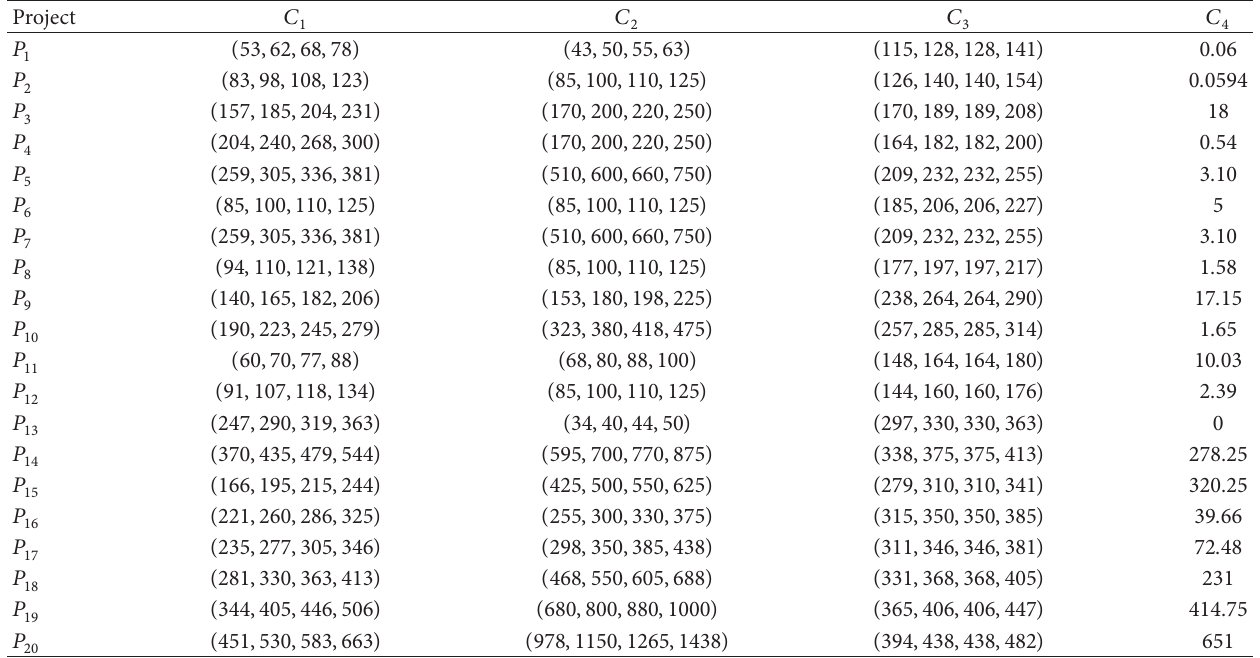
Table 1: Evaluation of R&D projects.